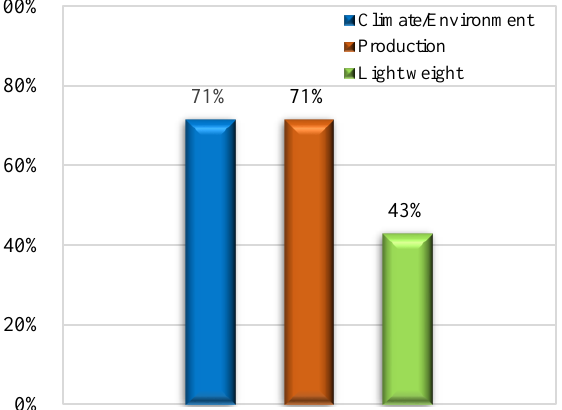
Figure 6. Advantages of constructing with wooden frames considered by UERs.